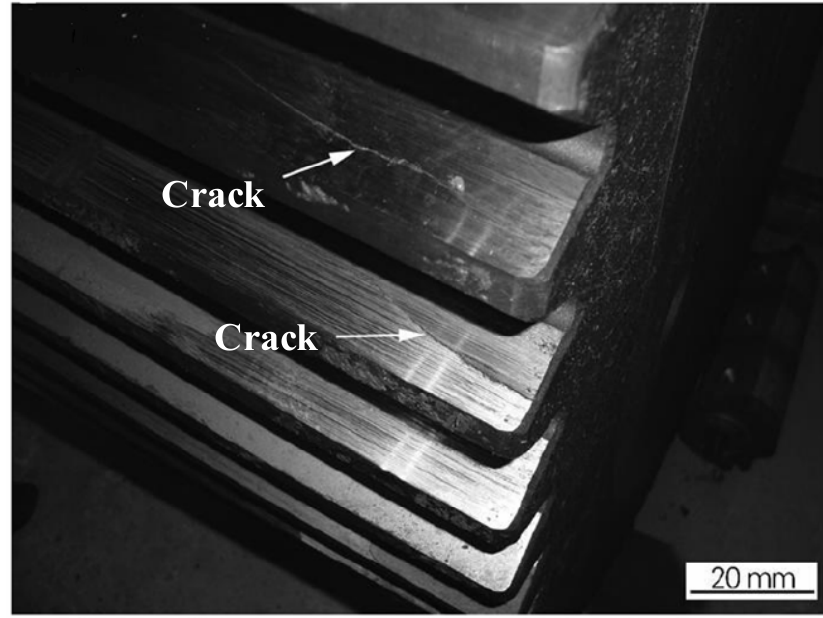
tooth surface. Figure 6 shows a photo of the tooth cracks on the flank zone in a real gear transmission [50]. A corresponding tooth model is depicted in Figure 7.